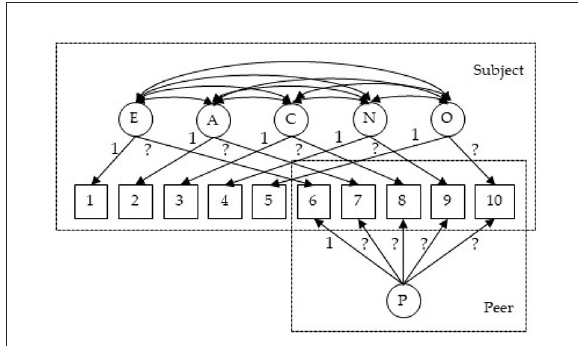
FIGURE1 Circles in the figure represent latent variables: E, Extraversion; A, Agreeableness; C, Conscientiousness; N, Neuroticism; O, Openness/Intellect; P, peer rater effect. Squares are observed ratings: measures 1–5 are self-reported scores and